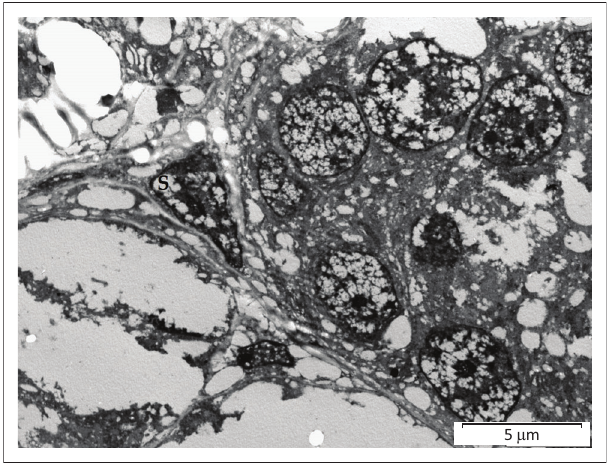
FIGURE 7: Transmission electron micrograph; renal paraganglioma. Sustentacular-like cells (S) between nests of neoplastic cells.